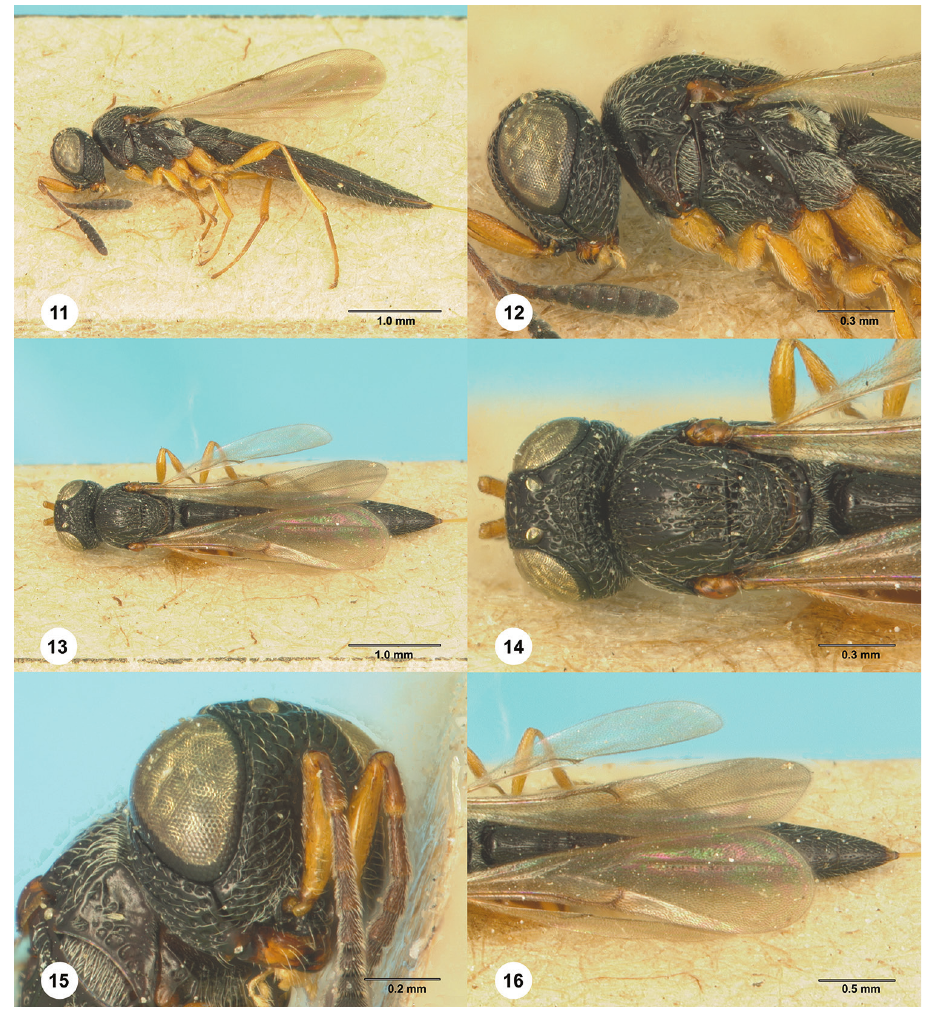
Figures 11–16. Habroteleia flavipes , female, holotype (MCSN 0001). 11 Lateral habitus 12 Head and mesosoma, lateral view 13 Dorsal habitus 14 Head and mesosoma, dorsal view 15 Head, lateral view 16 Metasoma and wings, dorsal